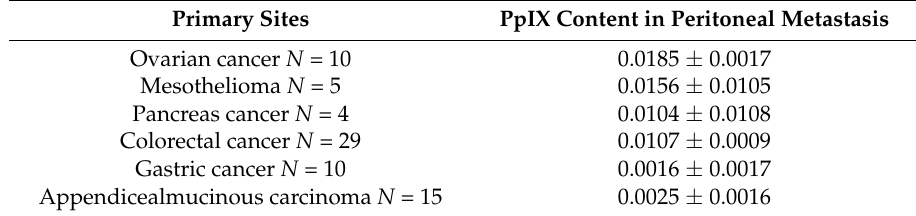
Table 4. PpIX contents in peritoneal metastases according to the primary site [12,19]. N = number of patients.